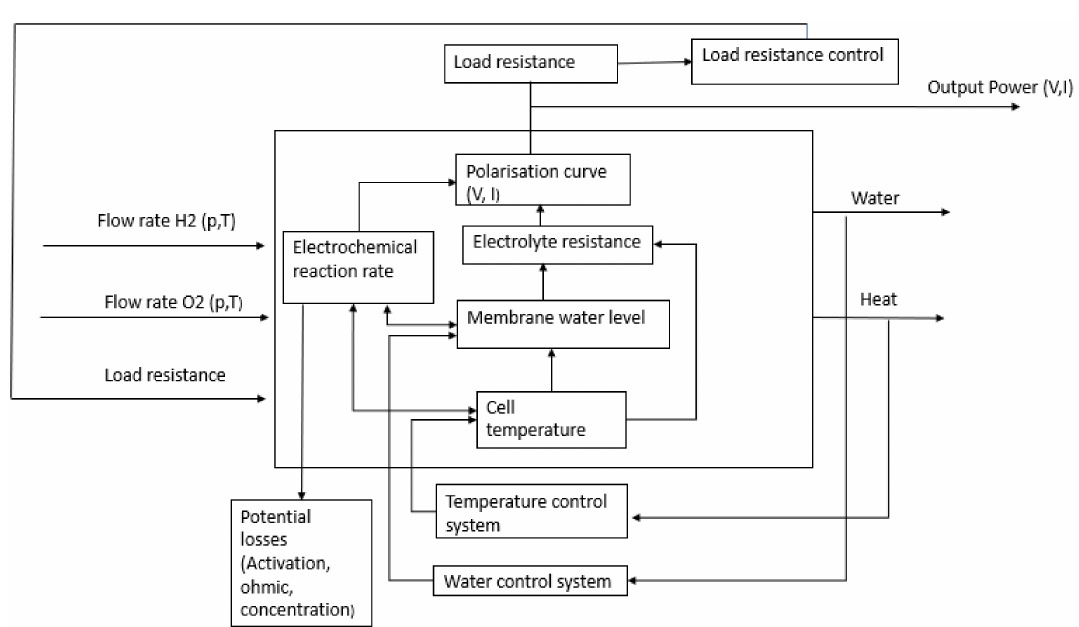
Figure 8. Logical scheme of a fuel cell operation showing the relationship between the operating parameters